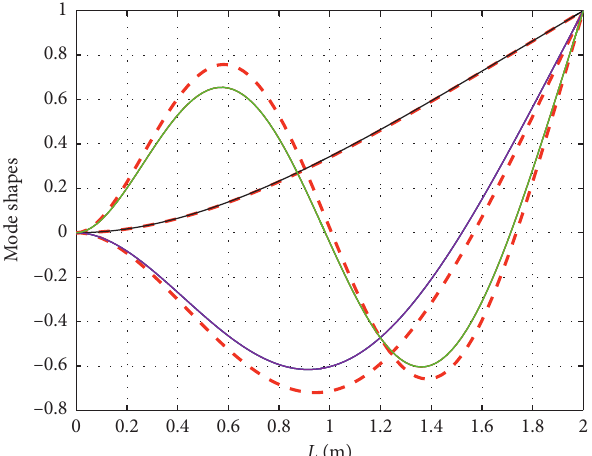
Figure 2: First three mode shapes normalized to the largest component equal to unity. Constant mass density (solid lines). Nonconstant mass density (dashed lines).